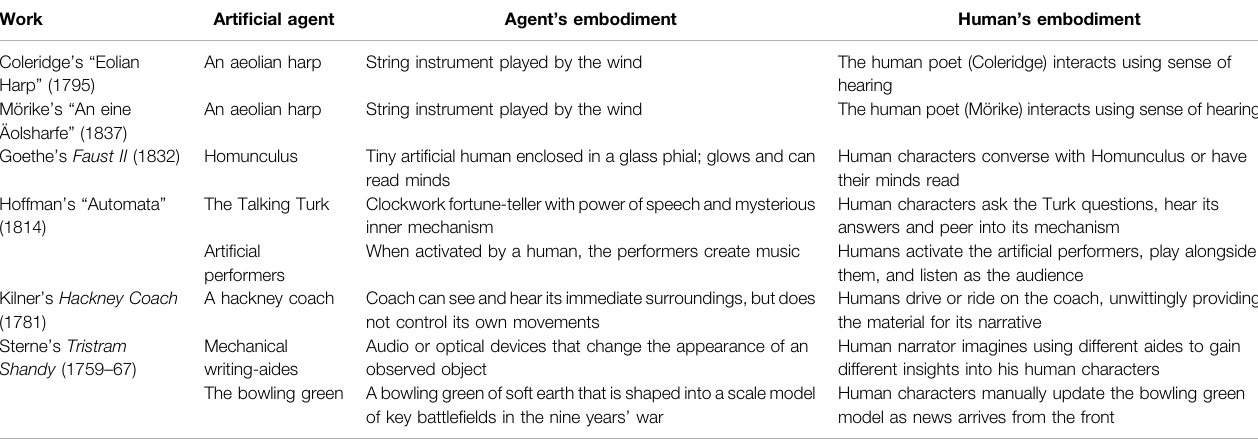
TABLE 1 | Embodied interactions in each example